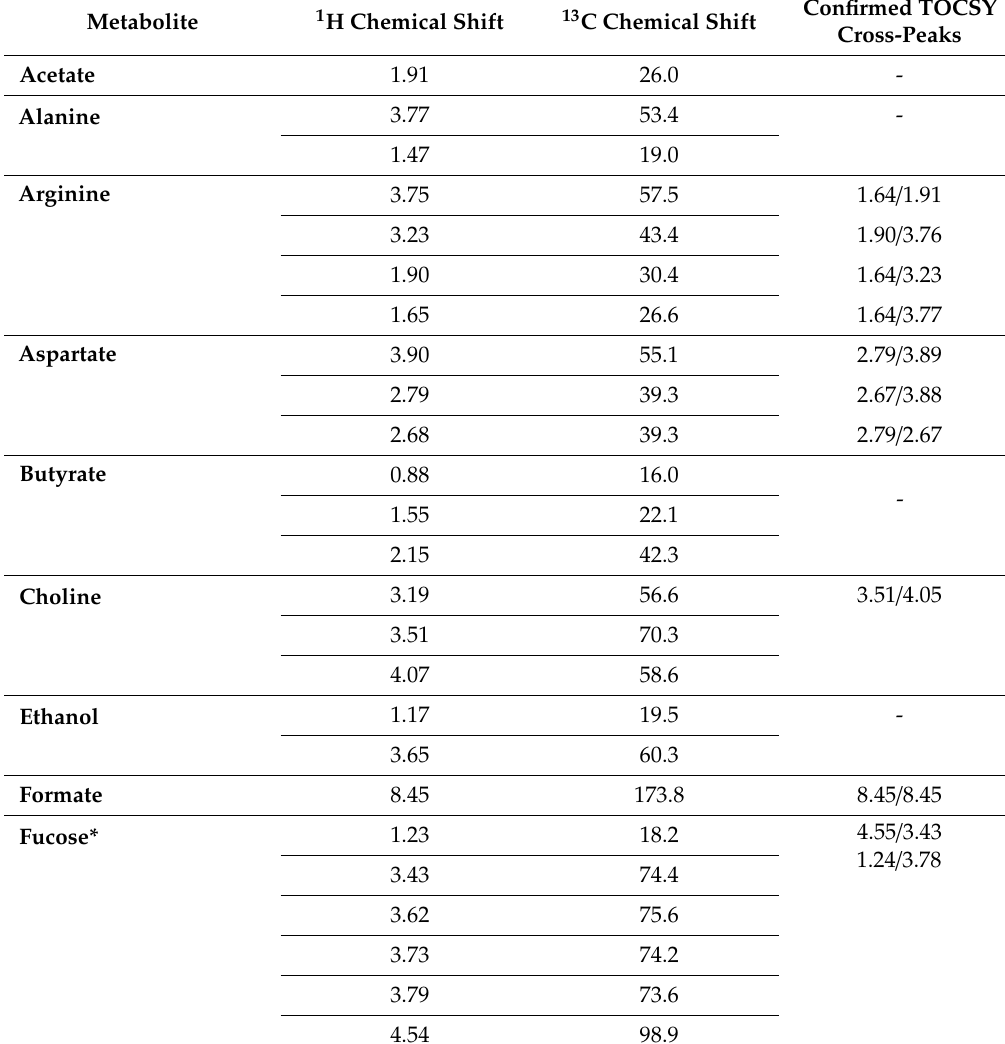
Table A1. One-month-old infant fecal